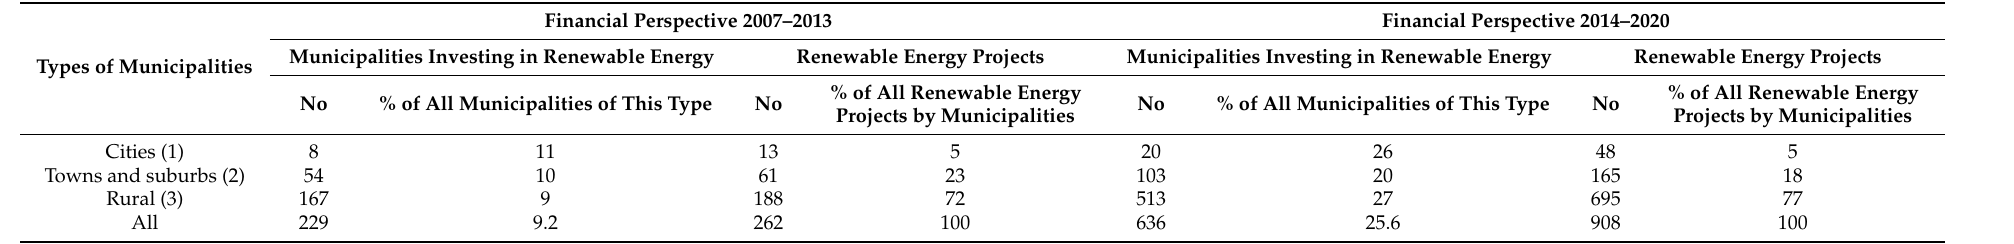
Table 3. Number of municipalities-investors and renewable energy projects under operational programs of 2007–2013 and 2014–2020.